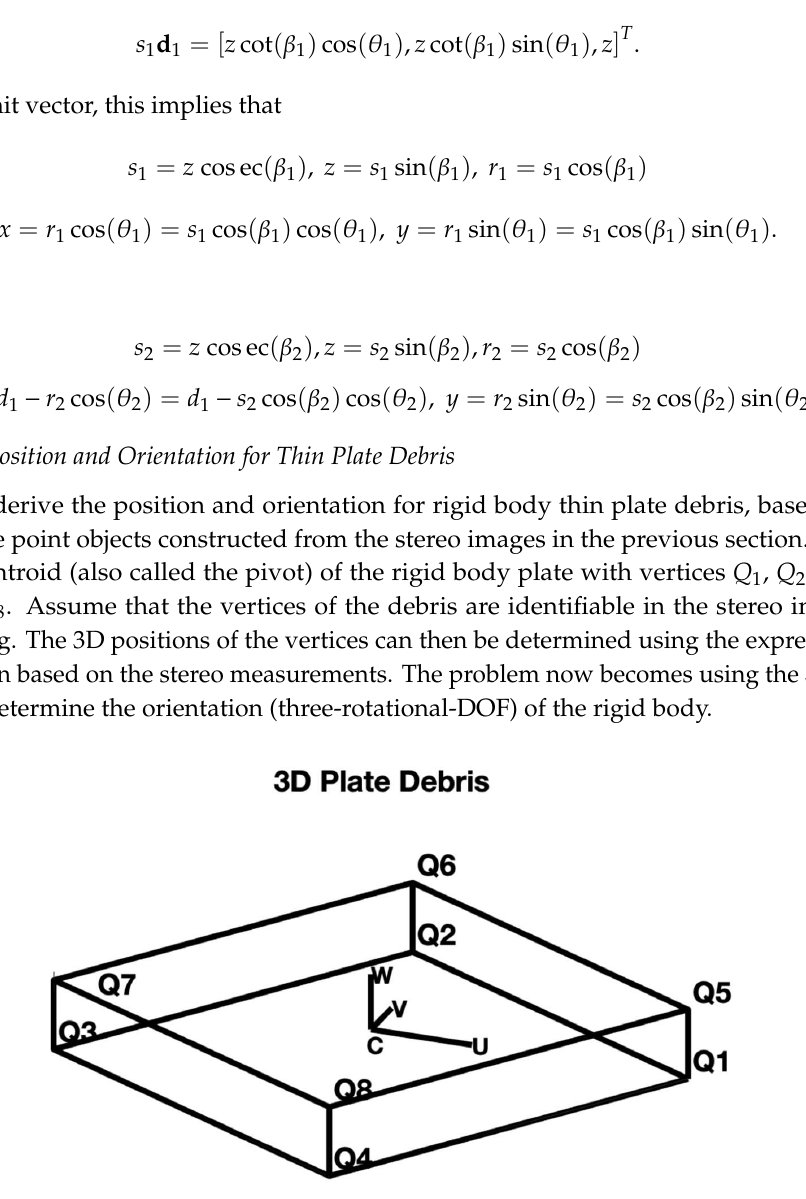
Figure 2. Rectangular plate representing debris.